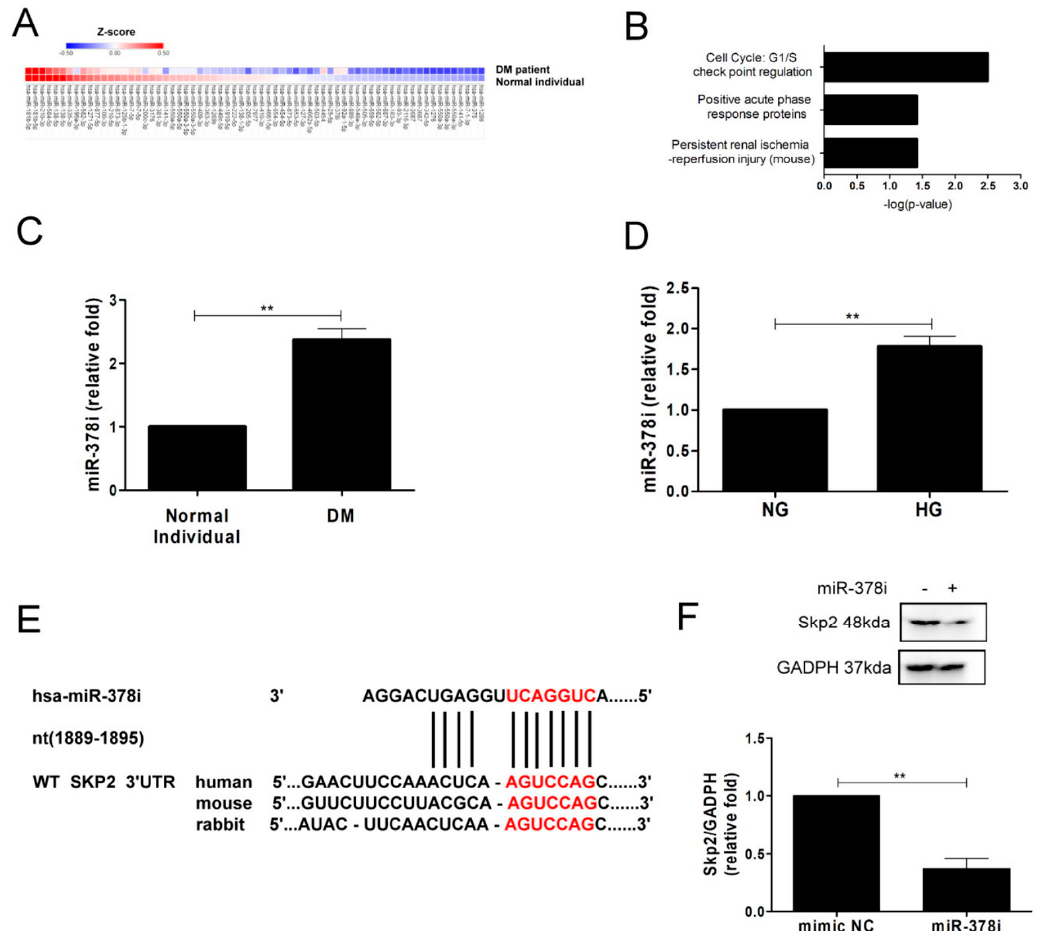
Figure 4. Identification of miR-378i-Skp2 interaction in cell senescence in diabetic PTECs. ( A ) The heat map revealed differentially expressed miRNAs from normal and diabetic PTECs with Z-score values. ( B ) The regulation of miR-378i on cell cycle, as predicted by IPA. ( C ) Increased miR-378i levels were found in PTECs from a type 2 DM patient ( n = 3). ( D ) HG increased miR-378i levels in human PTECs after three days of treatment ( n = 3). miR-378i levels were assessed by quantitative real-time PCR. ( E ) A schematic representation of sequence alignment of miR-378i and Skp2 mRNA 3’UTR. ( F ) miR-378i mimic suppressed Skp2 expression in HEK 293 cells. Cells were transfected with either control mimic or miR-378i mimic (100 nM) using DharmaFECT No. 1 Transfection Reagent. After 72 h transfection, western blot was utilized to measure Skp2 protein expression. The bar graph represents the mean ± S.E.M. ** p < 0.01 by Student’s t test.